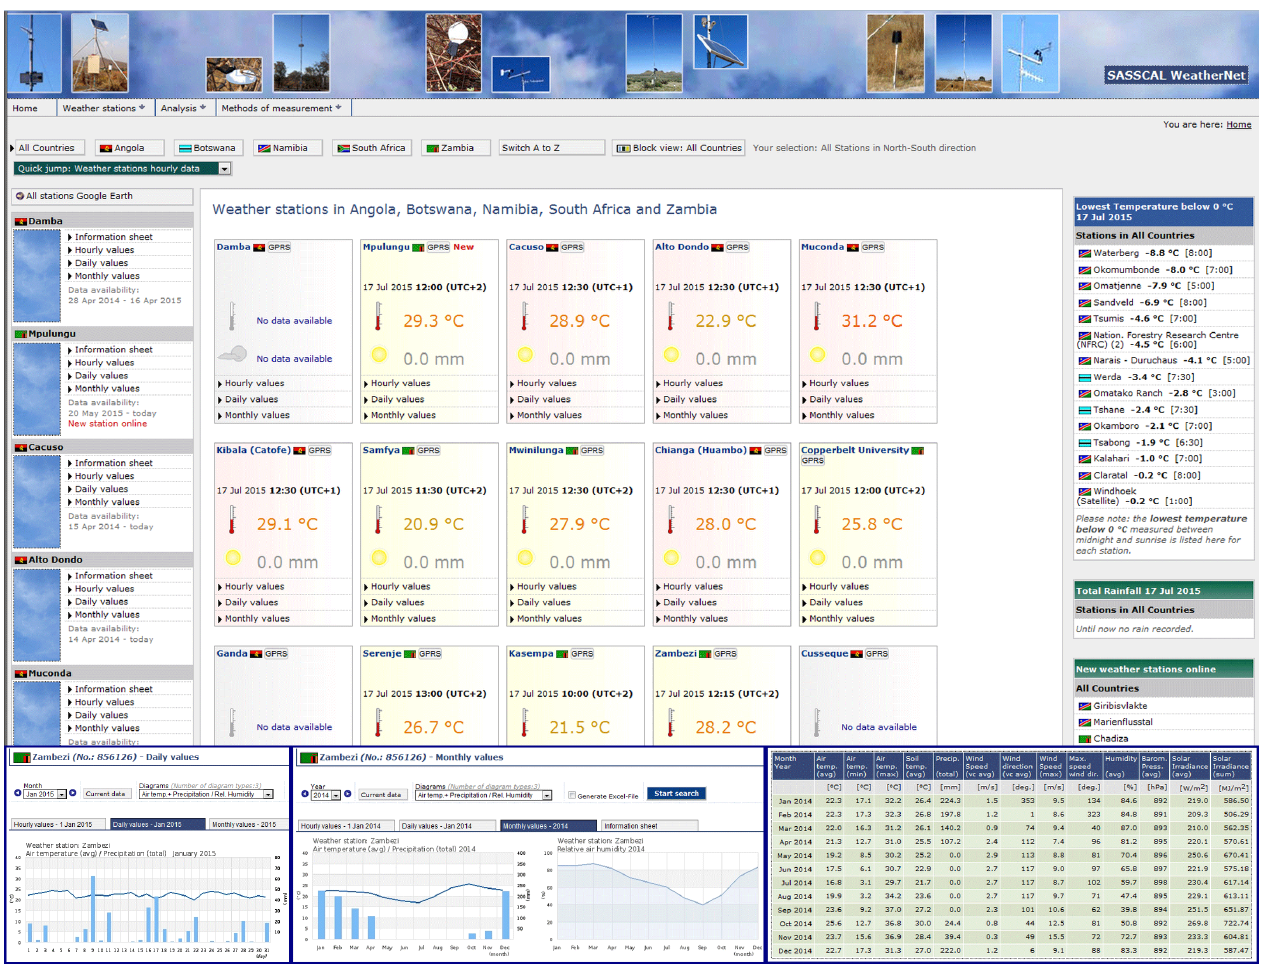
Figure 4. User interface and tools of the SASSCAL WeatherNet (www.sasscalweathernet.org). The upper figure shows the welcome page providing a general overview on actual climate conditions at each station and the actual rainfall status. The lower figures illustrate summaries of station-based daily rainfall and temperature in January 2015 (lower left), monthly summaries for 2014 (lower central) and statistics for 2014 (lower right) at an example for the Zambezi